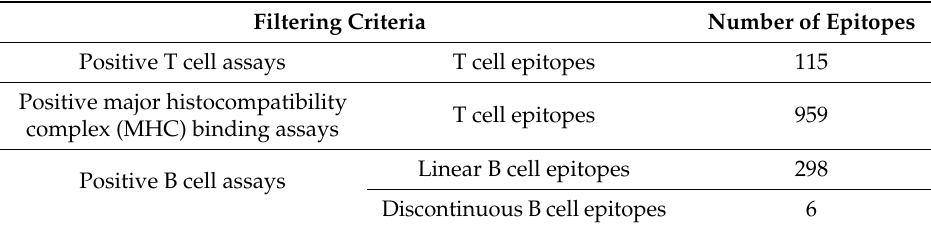
Table1. FilteringcriteriaandcorrespondingnumberofSevereAcuteRespiratorySyndromeCoronavirus (SARS-CoV)-derived epitopes obtained from the Virus Pathogen Database and Analysis Resource (ViPR)